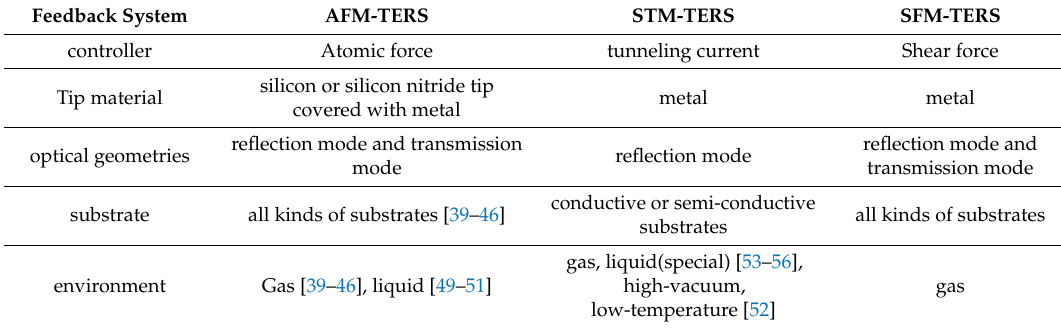
Table 2. Characteristics of the different feedback